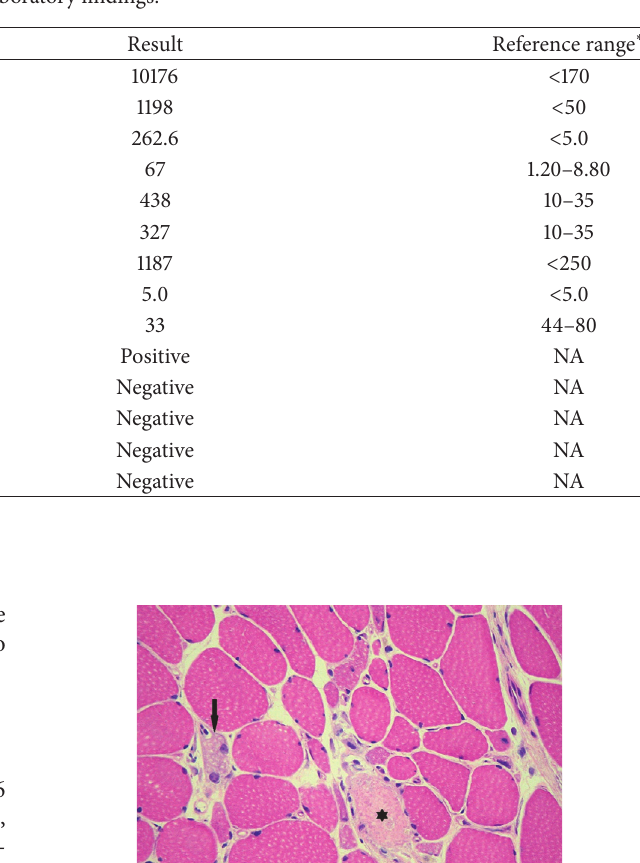
Table 1: Laboratory findings.